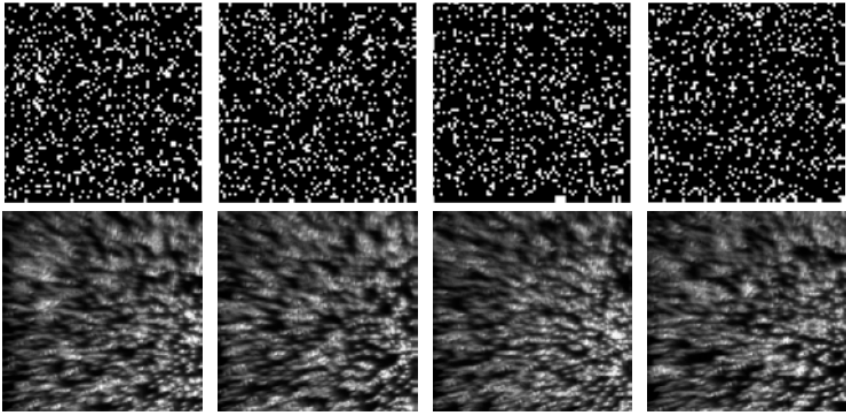
Figure 9. The comparison of the designed sampling patterns with the used image patterns.